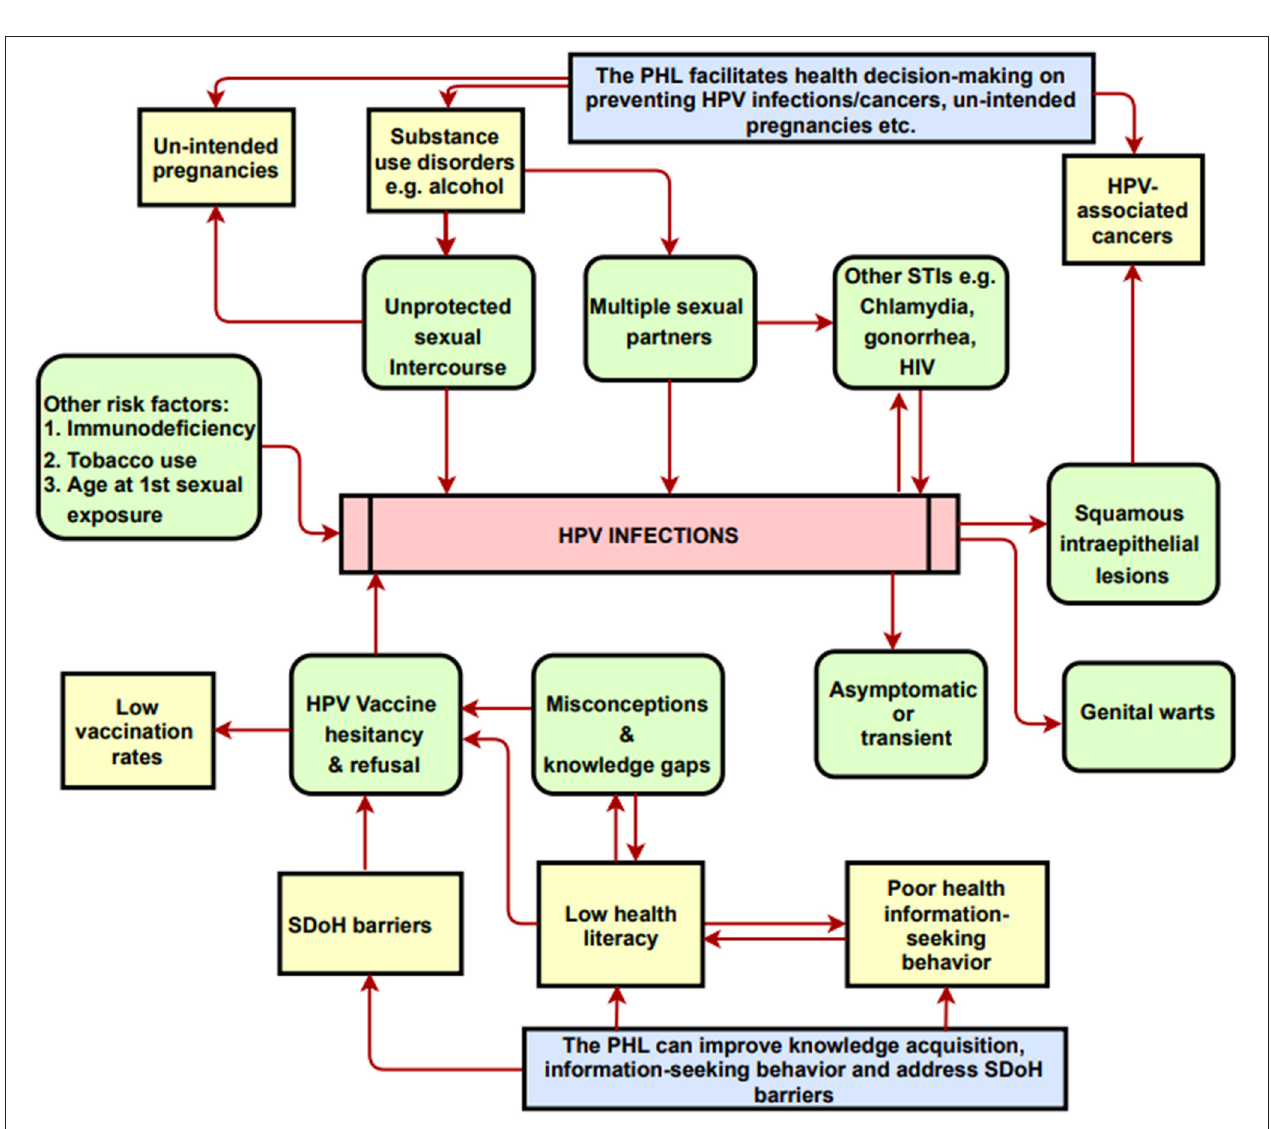
FIGURE 1 | A conceptual model on the potential impacts of the PHL-based app on knowledge and health decision-making. PHL, Personal Health Library; SDoH, Social Determinants of Health. The Conceptual Model Diagram depicts the risk factors and/or correlates for HPV infections and cancers. Arrows represent partial correlation/partial causality between the entities shown in the diagram. Diagram also shows how the PHL addresses risks factors and SDoH barriers.